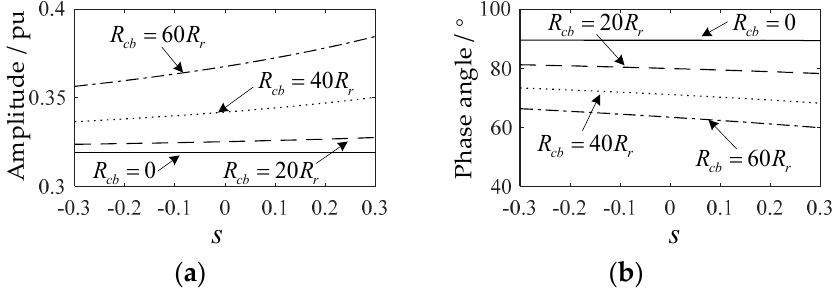
 Z : ( a ) amplitude; and ( b ) phase angle. Figure 9. Characteristic of Z ∗ w − : ( a ) amplitude; and ( b ) phase 